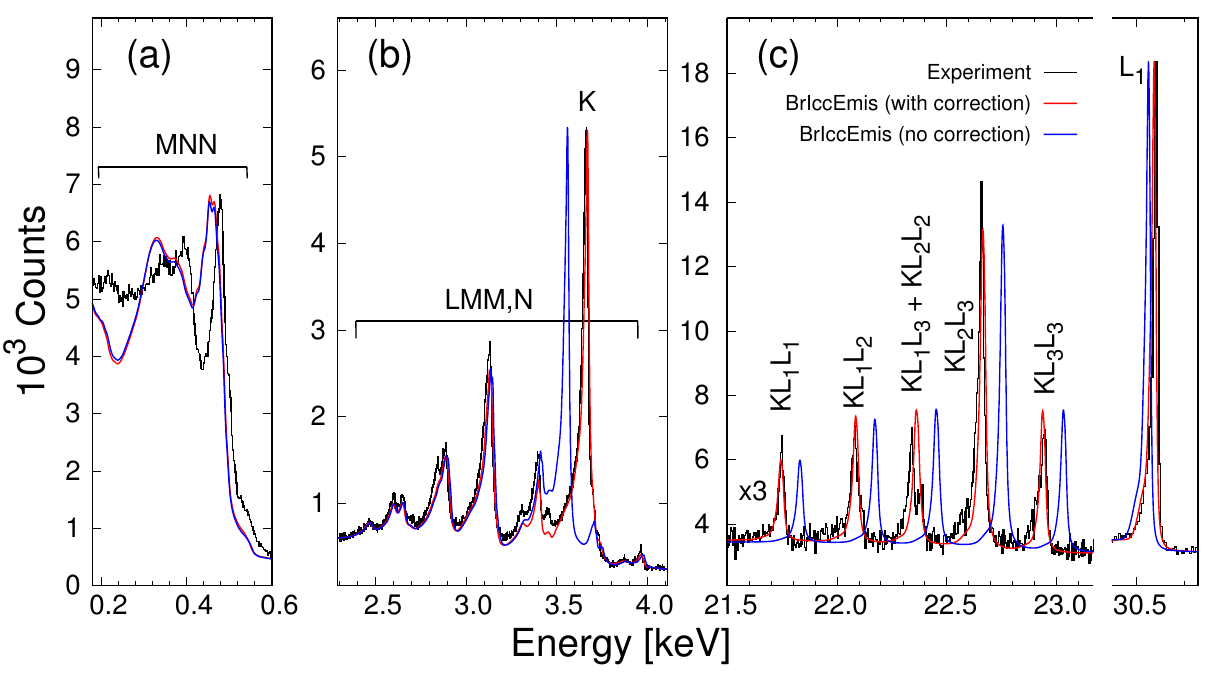
Figure 2. Auger electron spectra measured from the decay of 125 I. The red and blue curves indicate the calculated spectra from BrIccEmis with and without energy corrections applied referenced to the vacuum level. (a) The MNN Auger with the K conversion (not shown) electrons, (b) the LMM and LMN Auger with K conversion electrons and (c) the KLL Auger with the L 1 conversion electrons. Note the KLL Auger peaks are multiplied by a factor of 3 and a 7keV region between the KLL and L 1 peaks is omitted for clarity. All calculated spectra are scaled to match the intensities of the conversion